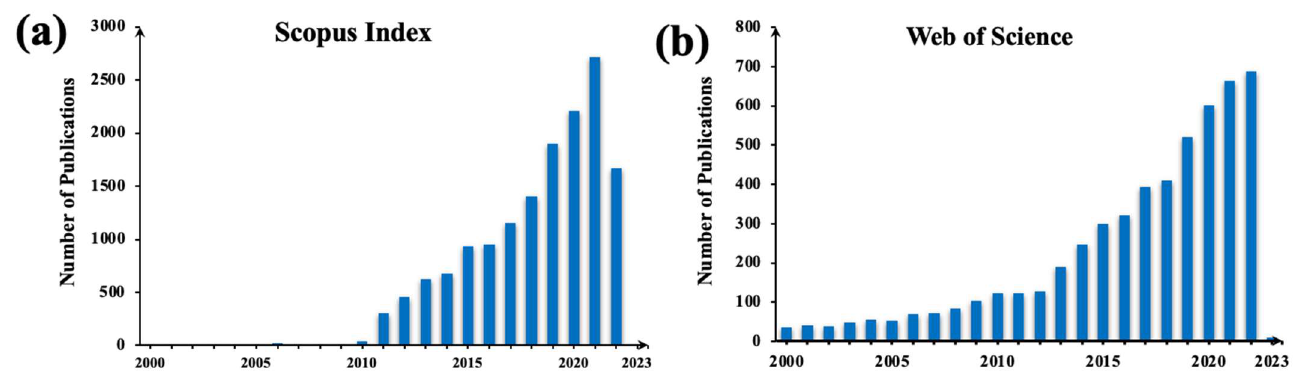
Figure 1. Year wise single-cell related article publications in the Scopus Index and Web of Science until 20th December 2022. ( a ) The data are adopted from Scopus Index articles ( b ) The data are adopted from Web of Science articles.